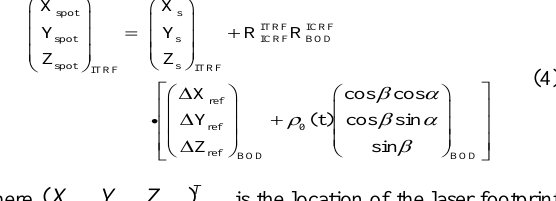
According to the geometric relationship between laser, satellite platform and earth ellipsoid, the spaceborne laser geometric calibration model is established by using satellite attitude, orbit and the geometric relationship between laser and satellite platform, its matrix form is shown